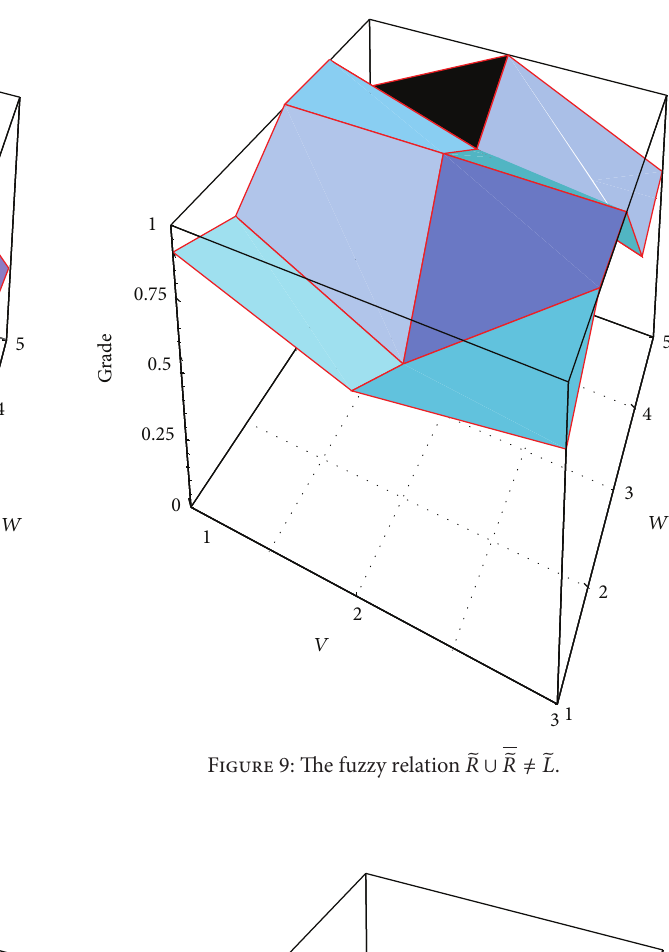
Figure 9: The fuzzy relation